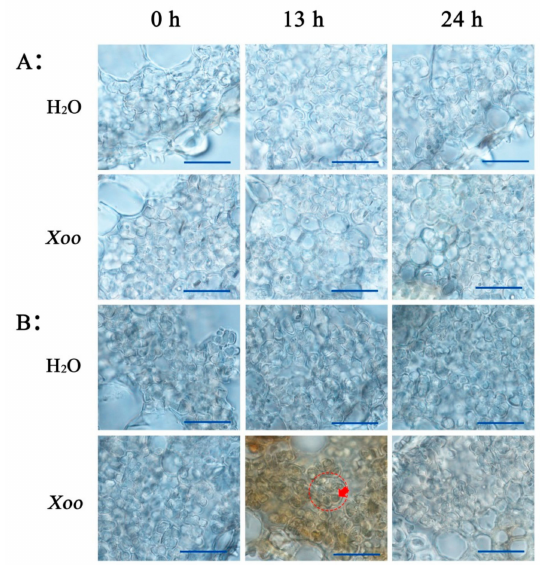
Figure 4. Subcellular localization of H 2 O 2 detected by After 3, 3-diaminobenzidine (DAB) staining in Dalixiang and O. meyeriana 0 h, 13 h, and 24 h after Xoo inoculation. Rice leaf sections were incubated in 3, 3-diaminobenzidine (DAB) solution and then examined in an inverted microscope. ( A ): Dalixiang, ( B ): O. meyeriana . Red circle indicates a mesophyll cell and the arrow indicates a chloroplast. Scale bars = 20 µ